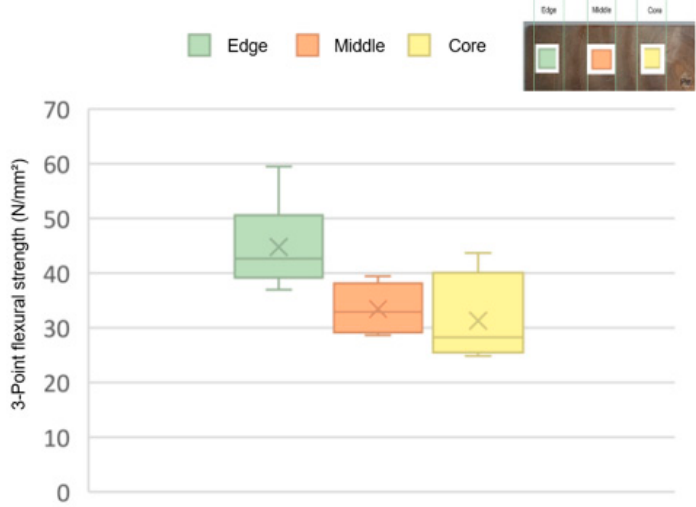
Figure 13. Modulus of rupture in the cross-section of the Paulownia’s tree stem.